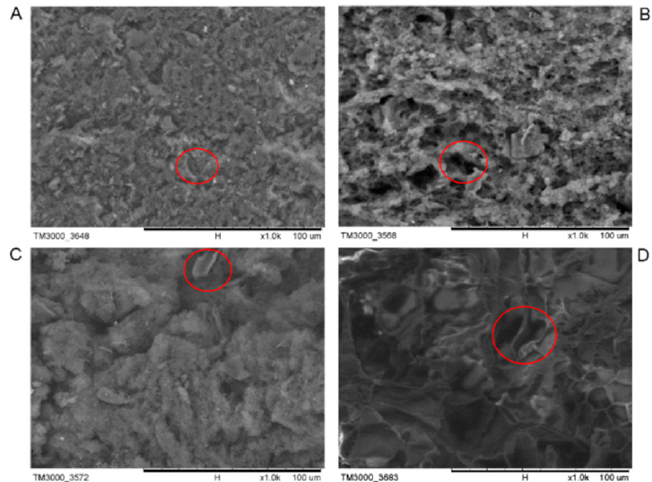
Figure 6. Scanning electron micrographs of tofu made with different additions of soybean fiber and commercially available lactone tofu at 1000 × magnification. ( A ) Commercially available lactone tofu. ( B ) Lactone tofu with 5% cellulose. ( C ) Lactone tofu with 10% cellulose. ( D ) Lactone tofu with 15% cellulose. The circles represent cellulose fragments and pores.